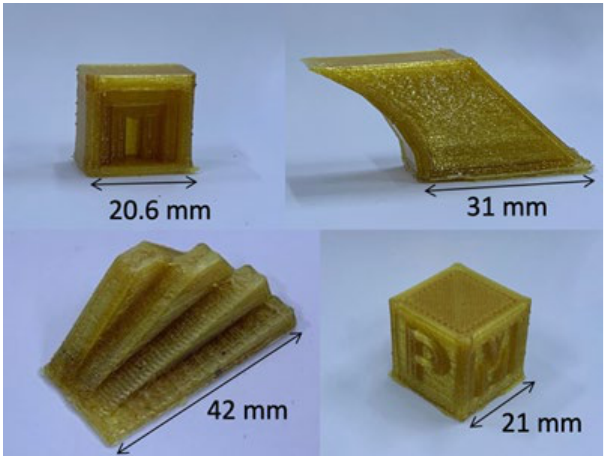
Figure 2. 25% layer fan speed specimens. Top: left bridge test, right overhang test. Bottom: left staircase effect test, right engraved cube.